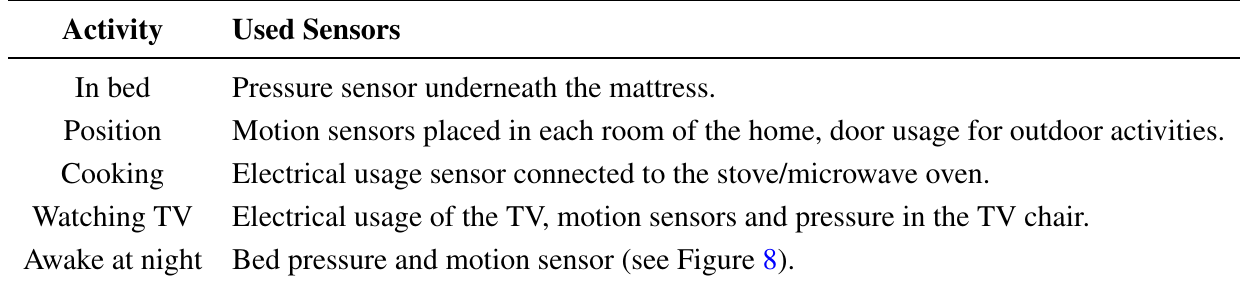
Table 1. Activities that can be recognized by the context recognition